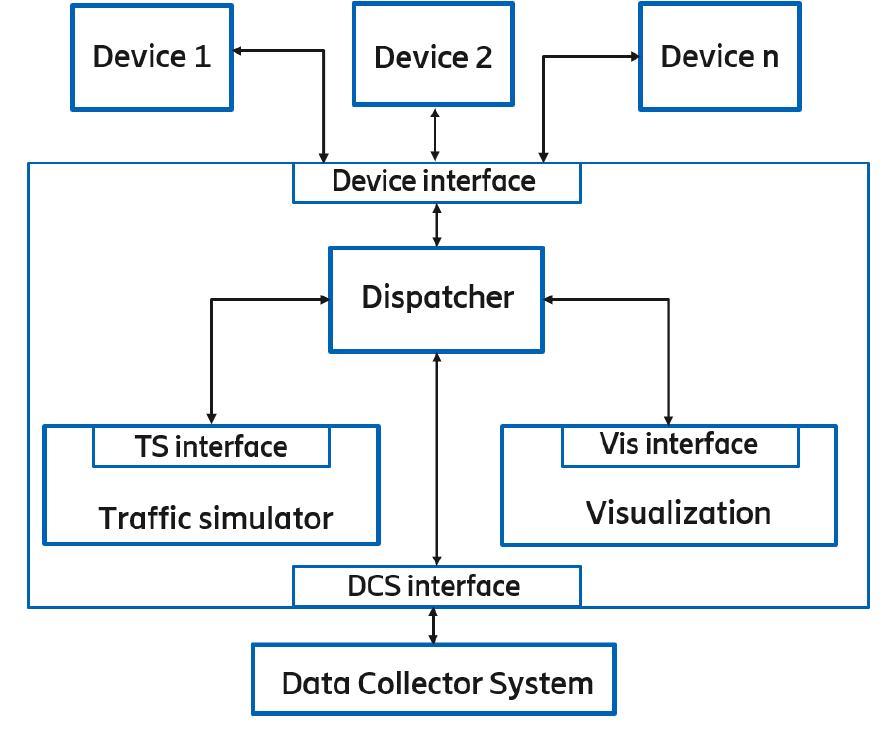
Figure 7. On-site computer